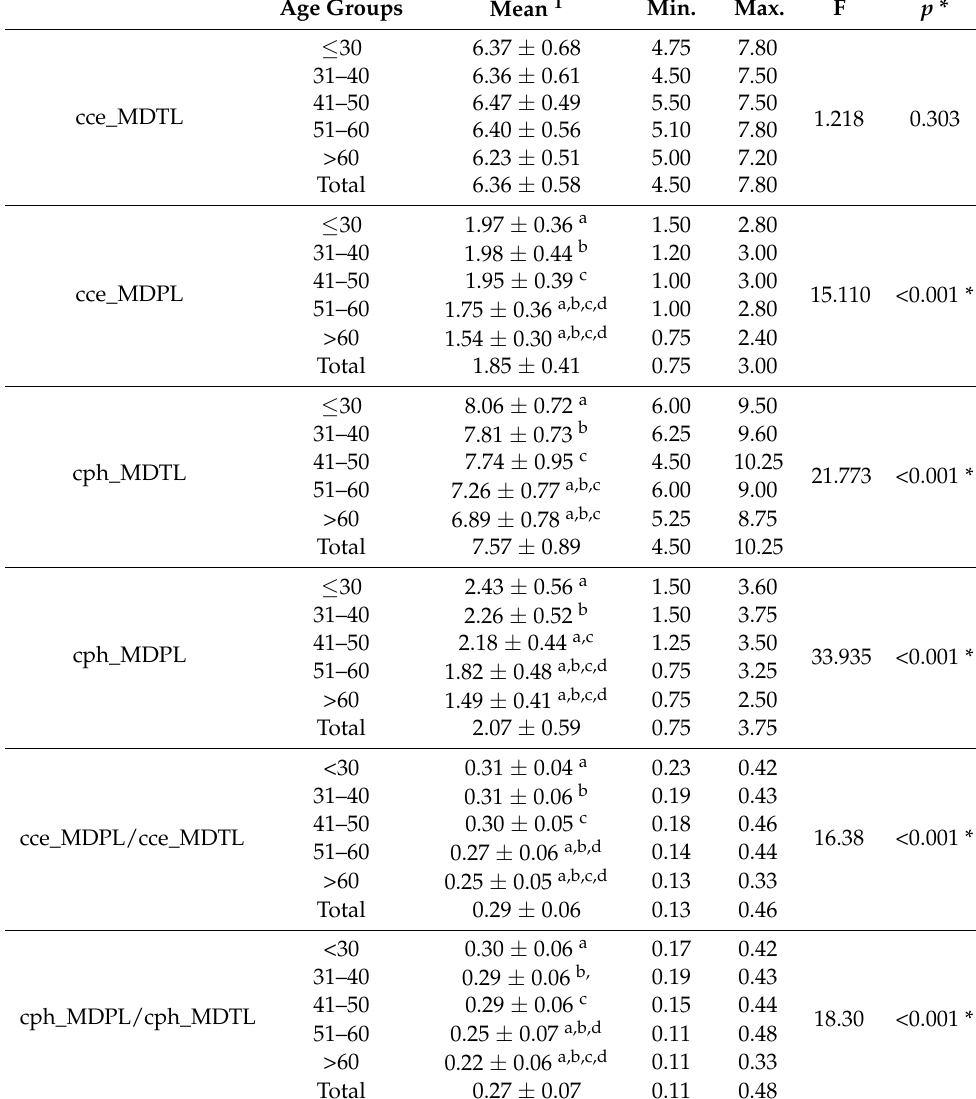
Table 2. Differences in coronal linear measurements and ratios between age